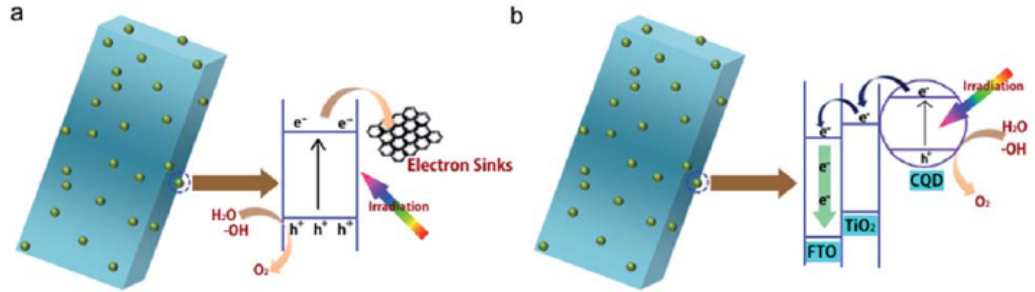
Figure 5. Possible uses of CDs (yellow spheres) in a photocatalytic application: ( a ) as electron acceptor (electron sink) from the semiconductor surface (blue block) increasing the photocatalytic activity of the semiconductor; ( b ) as electron donor creating a cascade of electrons from CDs lowest unoccupied molecular orbital (LUMO) to semiconductors. Reproduced with permission from [157]. Copyright Royal Society of Chemistry,